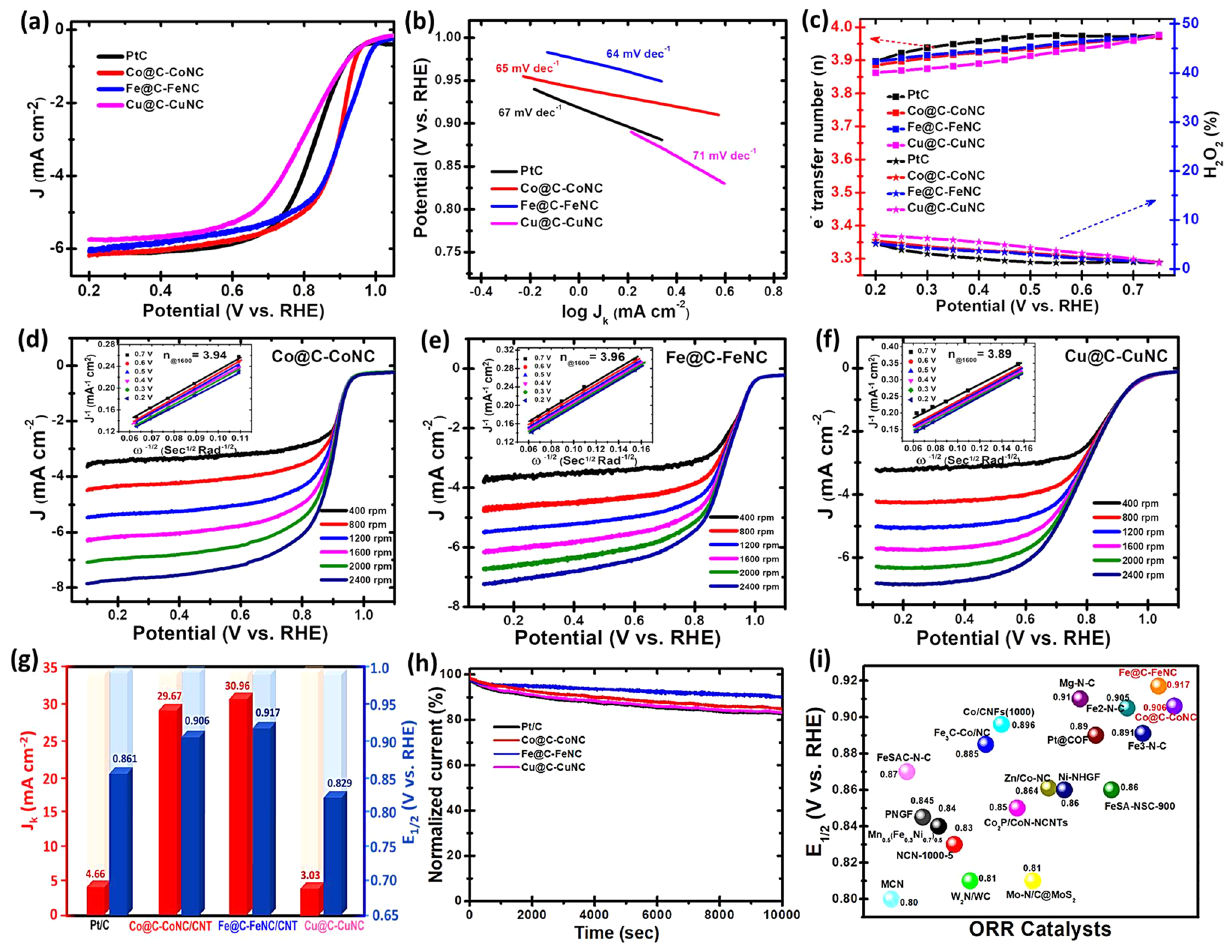
Fig. 4 a ORR polarization curves and b their corresponding Tafel plots for Co@C-CoNC, Fe@C-FeNC, Cu@C-CuNC, and the benchmark Pt/C catalysts at a rotation rate of 1600 rpm in O 2 ‐ saturated 0.1 M KOH electrolyte; c Electron-transfer number ( n ) (top) and H 2 O 2 yield (bot- tom) vs. Potential; The ORR polarization curves at different rotating rates of: d for Co@C-CoNC, e for Fe@C-FeNC and f for Cu@C-CuNC, in which the insets are K − L plots and electron-transfer numbers; g Comparison of J k at 0.85 V and E 1/2 of Co@C-CoNC, Fe@C-FeNC and Cu@C-CuNC catalysts with Pt/C; h Durability tests at 0.67 V (at 1600 rpm); and i Comparison of the ORR activity of the present study with recently reported